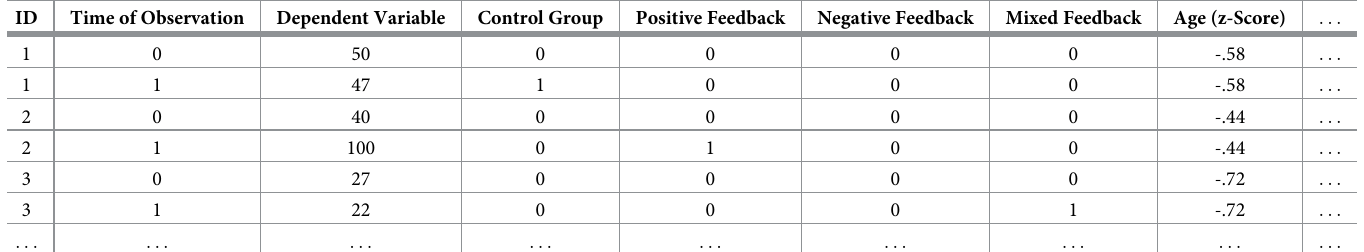
Table 4. Illustration of the dataset (long